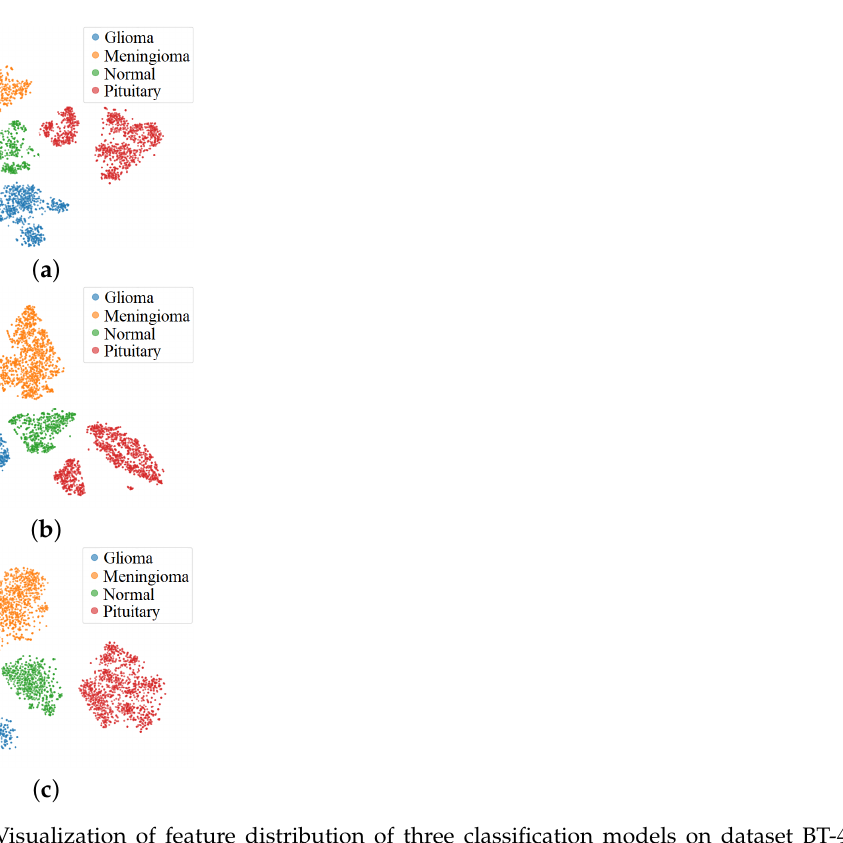
Figure 8. Visualization of feature distribution of three classification models on dataset BT-4C. ( a ) ResneSt, ( b ) ResneSt + bilinear pooling, ( c ) ResneSt +